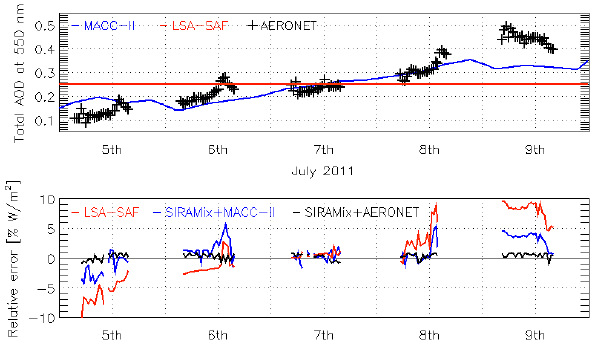
Figure 6. (top) evolution of the total AOD over Sede Boqer from the 5 to 9 July according to MACC-II and AERONET. The static AOD adopted by the LSA-SAF method is also shown. (bottom) Bias in Wm − 2 between the estimated and in situ global DSSF from the BSRN station. DSSF is estimated using the LSA-SAF approach and the SIRAMix method using either MACC-II (i.e., SIRAMix + MACC-II) or AERONET (i.e., SIRAMix + AERONET) AOD